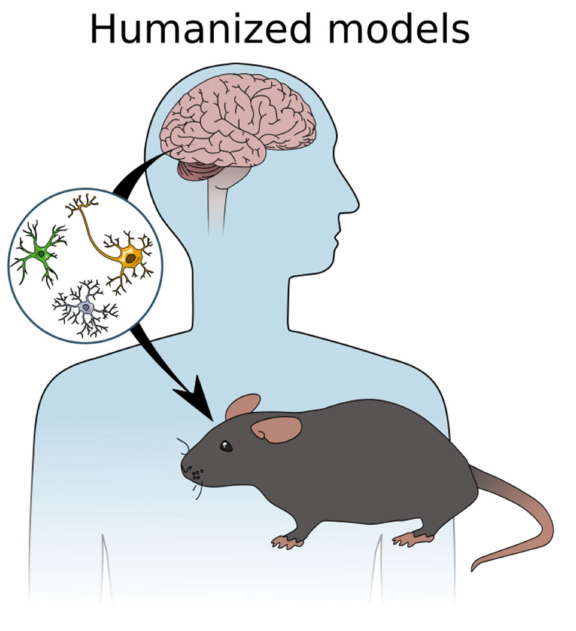
Figure 4. In animal models using iPSCs, progenitor cells are derived from a patient’s somatic cells and differentiated to neuronal or glial precursors. These cells are then transplanted to the rodent brain and studied in situ in order to make a humanized model of